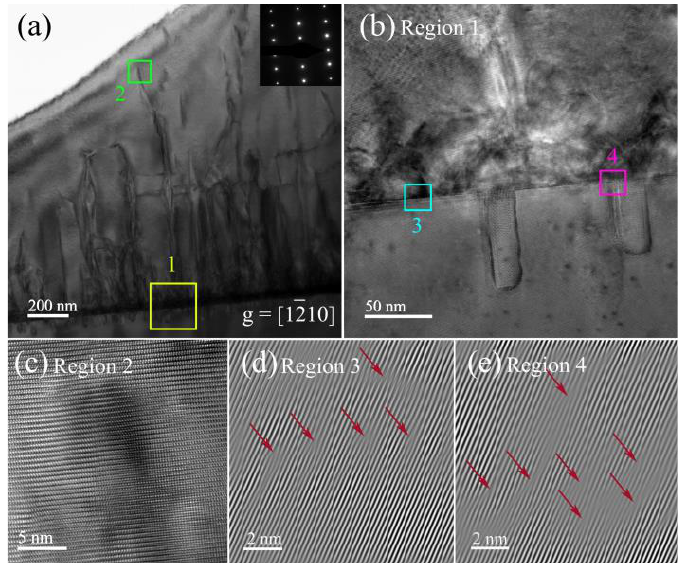
Figure 4. ( a ) Cross-sectional TEM image of AlN sample Sc. ( b , c ) Partial enlarged images correspond- ing to region 1 and region 2 in ( a ). ( d , e ) Inverse fast Fourier transform images for region 3 and region 4 in ( a ).